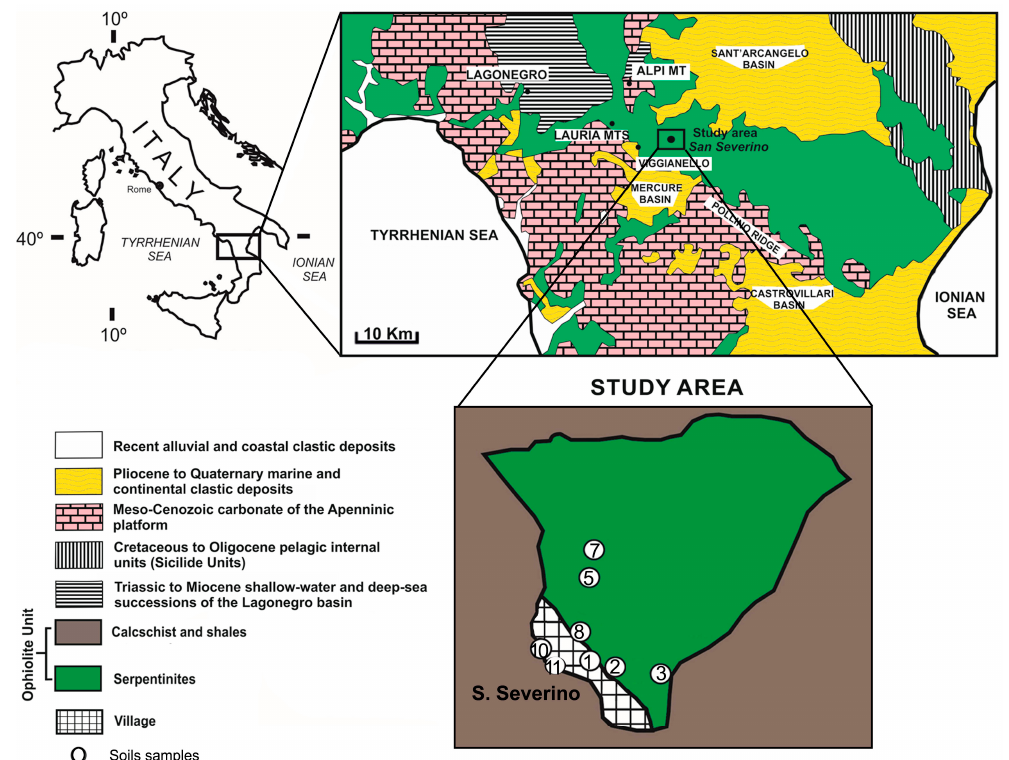
Figure 1. Geological map of the Calabria-Lucania border (modified after [30]) and study area location with sampling sites.